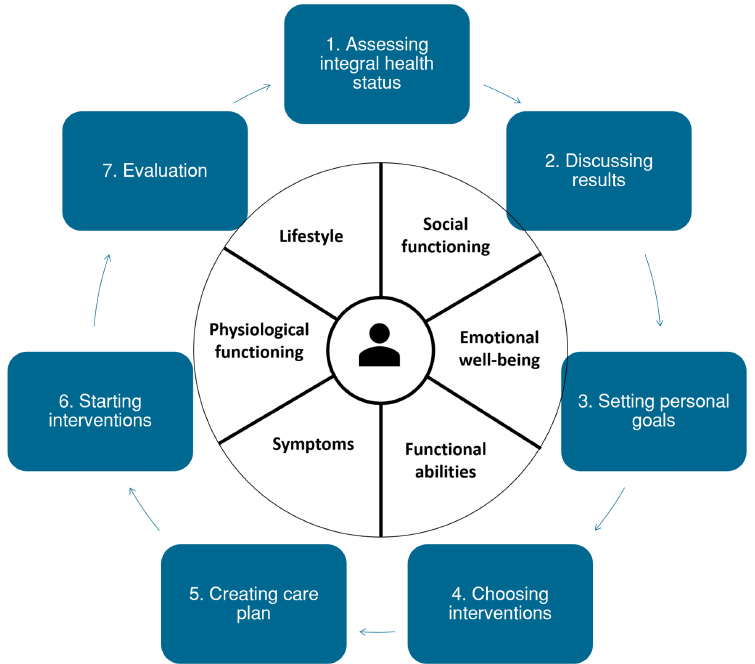
Figure 4. Schematic representation of the Person ‐ Centred and Integrated Care (PC ‐ IC) approach for the management of patients with chronic diseases and multimorbidity in primary care.